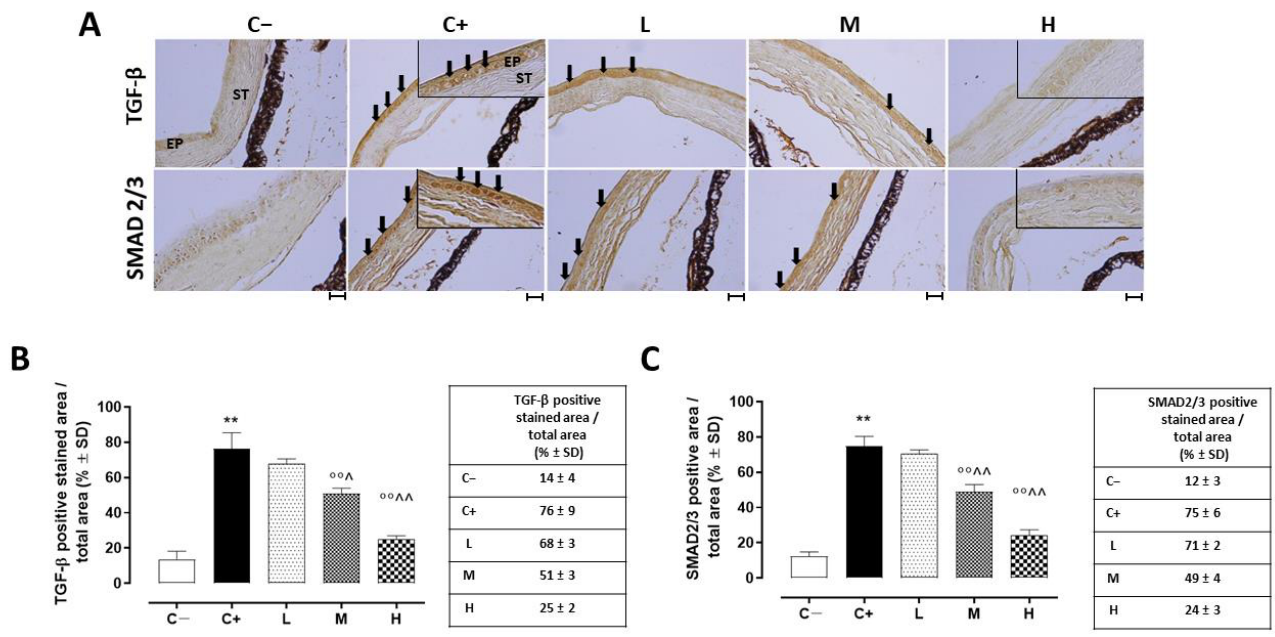
Figure 7. ( A ) Representative immunohistochemistry images of corneal TGF- β and SMAD2/3 and the relative quantization of TGF- β ( B ) and SMAD2/3 ( C ) staining (black arrows), expressed as percentages ± SDs of the positive stained area/total area in the TSP-1 KO mice euthanized at 6 weeks of age as a negative control for SS-associated dry eye (C − ); TSP-1 KO mice euthanized at 12 weeks of age as a positive control for SS-associated dry eye (C+); and TSP-1 KO mice supplied with low (L), medium (M), and high (H) doses of vitamin D3 (1000, 8000, and 20,000 IU/kg/week, respectively) from week 6 to week 12 of age. N = 7 corneas per group; EP: corneal epithelium; ST: stroma. Scale bar 20 µm; magnification 40×. ** p < 0.01 vs. C − ; °° p < 0.01 vs. C+; ^ p < 0.05 and ^^ p < 0.01 vs. L. In addition, the TGF- β levels detected in the C+ group’s corneas (273 ± 76 ng/L; p < 0.01 vs. C+) were elevated compared to those of the C- mice (Figure 8). Figure 8. Corneal TGF- β levels (ng/L ± SD) in the TSP -1 KO mice euthanized at 6 weeks of age as a negative control for SS-associated dry eye (C − ); TSP-1 KO mice euthanized at 12 weeks of age as a positive control for SS-associated dry eye (C + ); and TSP-1 KO mice supplied with low (L), medium (M), and high (H) doses of vitamin D3 (1000, 8000, and 20,000 IU/kg/week, respectively) from week 6 to week 12 of age. N = 5 corneas per group. ** p < 0.01 vs. C − ; °° p < 0.01 vs. C+; ^ p < 0.05 and ^^ p < 0.01 vs. L. While the L mice showed no differences in corneal TGF- β staining (68 ± 3%, p > 0.05 vs. C+) and levels (228 ± 16 ng/L, p > 0.05 vs. C+) compared to the C+ group, both the TGF- β immunoreactivity and levels were found to be significantly reduced in the M (51 ± 3%